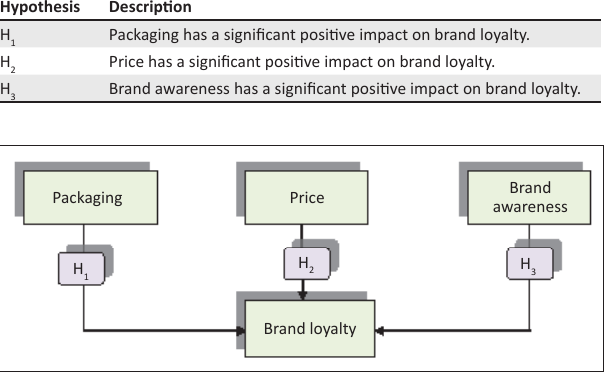
FIGURE 1: Hypothesised model of the impact of packaging, price, brand awareness on brand awareness.